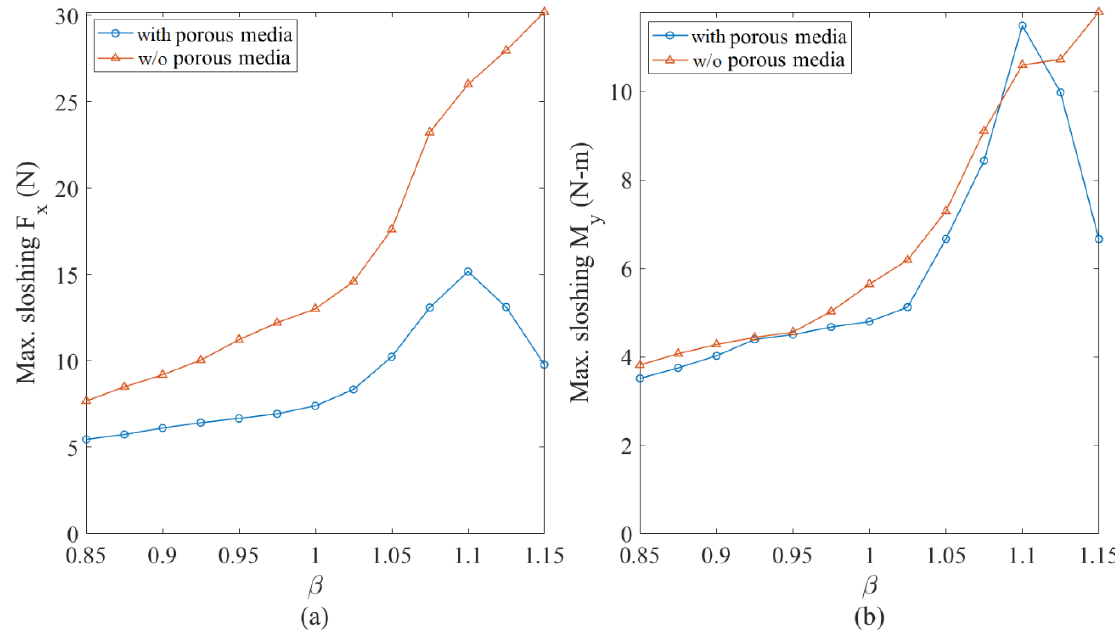
Figure 35. The frequency responses of the maximum sloshing reactions for the small-wave case: ( a ) horizontal force; ( b ) overturning moment.